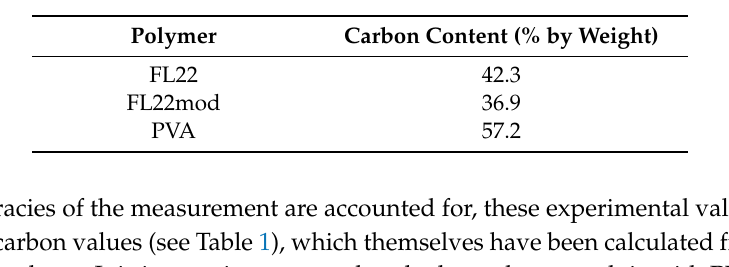
Table 2. Measured polymer carbon